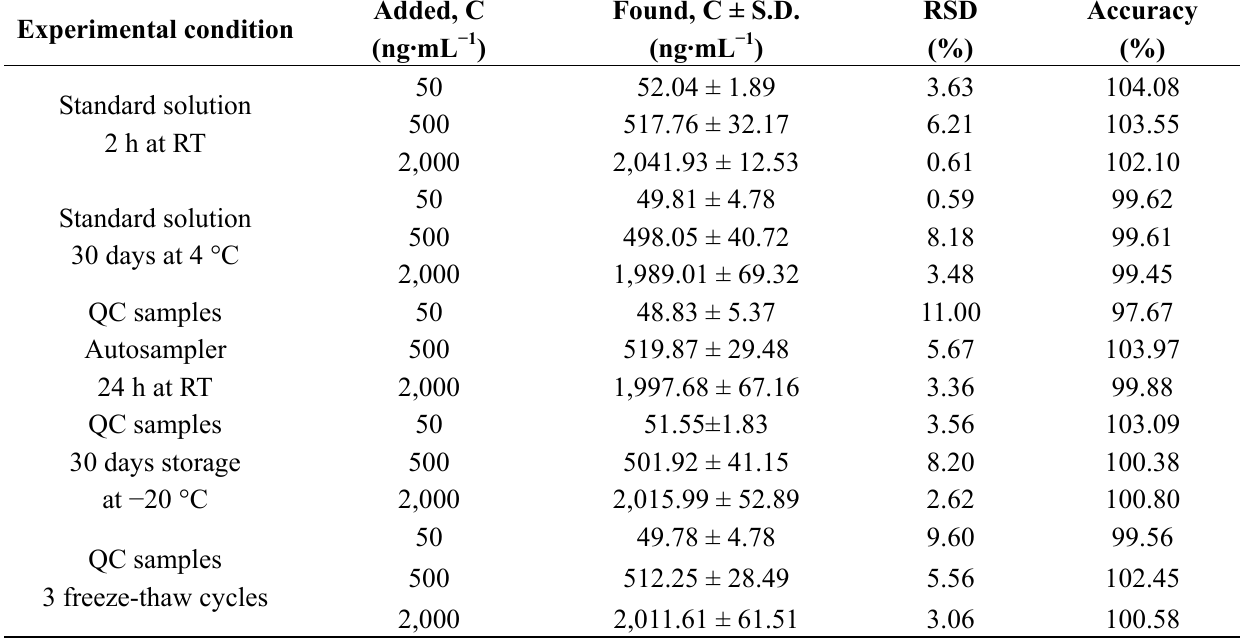
Table 4. Stability of salidroside (n =